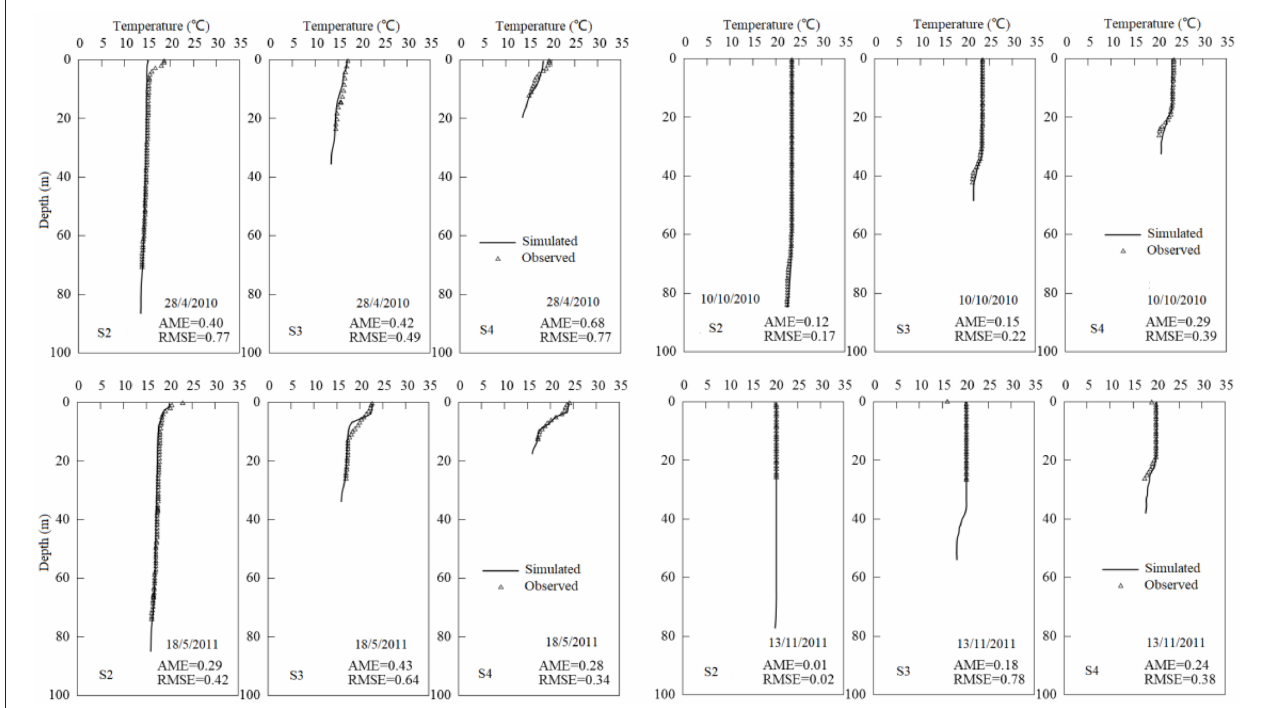
FIGURE 3 | Observed and modeled water temperature profiles of velocity at sites S2, S3, and S4.